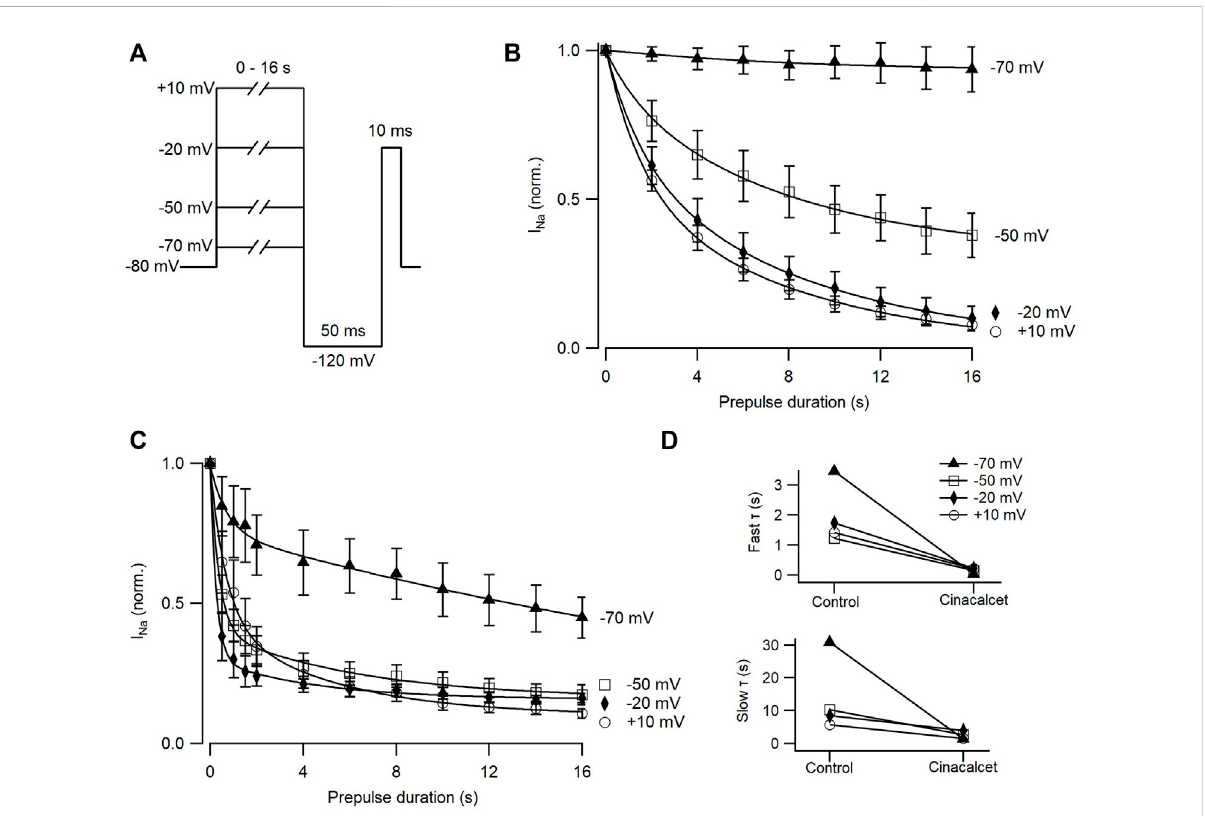
FIGURE 4 Cinacalcet af fi nity does not correlate with development of slow inactivation. (A) Voltage protocol used to show development of slow inactivation with increased time at various voltages. Measurements were taken by applying a variable time step to either − 70, − 50, − 20, or +10 mV from a holding potential of − 80 mV, and delivering a test pulse to − 20 mV following a 50 ms recovery period at -120 mV. (B) Time course of development of slow inactivation in control conditions, with conditioning pulses as in A from − 70 ( fi lled triangle; n = 5), -50 (open square; n = 5), − 20( fi lleddiamond;n=5),or+10 mV(opencircle;n=5) fi ttoadoubleexponential.Currentswerenormalizedtothe fi rstcurrentateachvoltage when there was no inactivating pulse. (C) Time course of development of slow inactivation following complete inhibition by 5 µM cinacalcet, with conditioning pulses asinA from − 70( fi lled triangle;n=6), − 50(open square; n=6), − 20 ( fi lled diamond; n= 6),or+10 mV(open circle;n=5) fi ttoa double exponential. Currents were normalized to the fi rst current at each voltage when there was no inactivating pulse. (D) Plot of average fast (top) and slow (bottom) τ values in control and following inhibition by